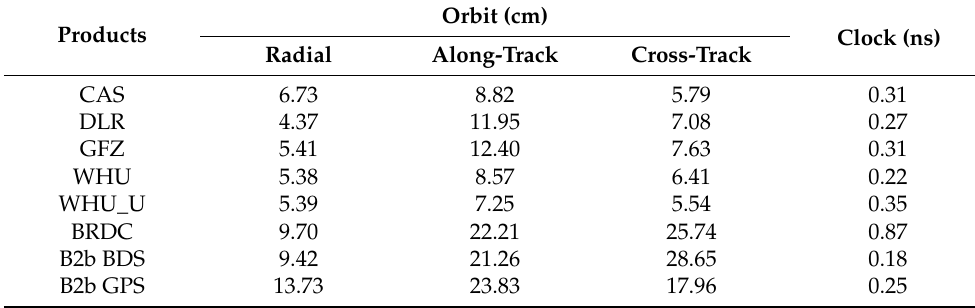
Table 4. The average accuracies of real-time orbit and clock